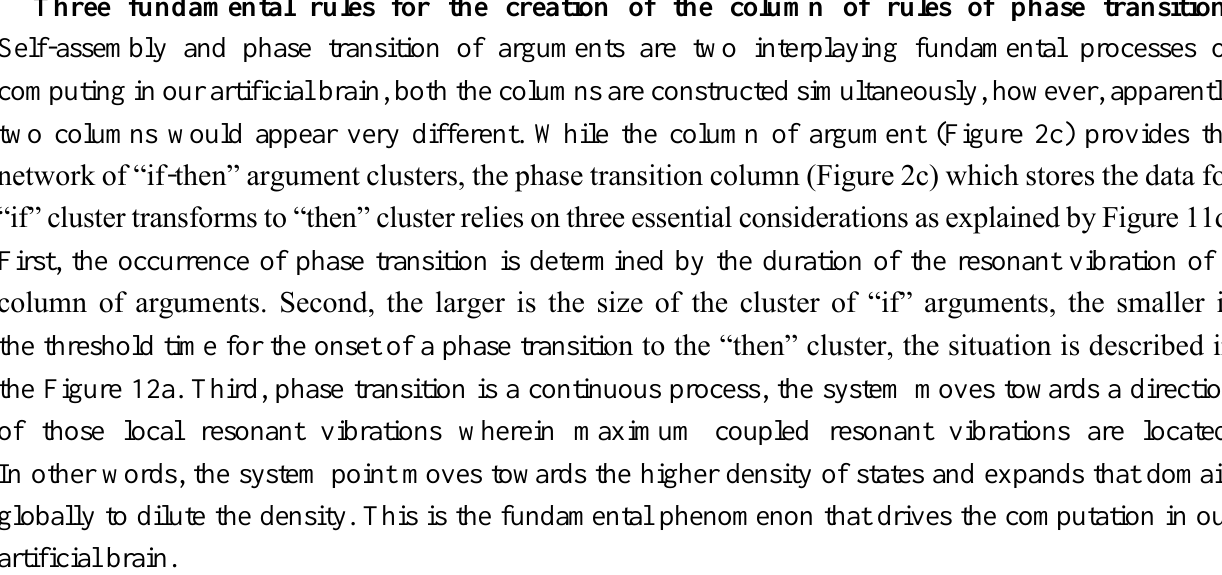
Figure 12. ( a ) The self-assembly of phase transition rules, fractal seeds of iterative function systems form clusters of clusters, it starts from sing seed to the largest brain